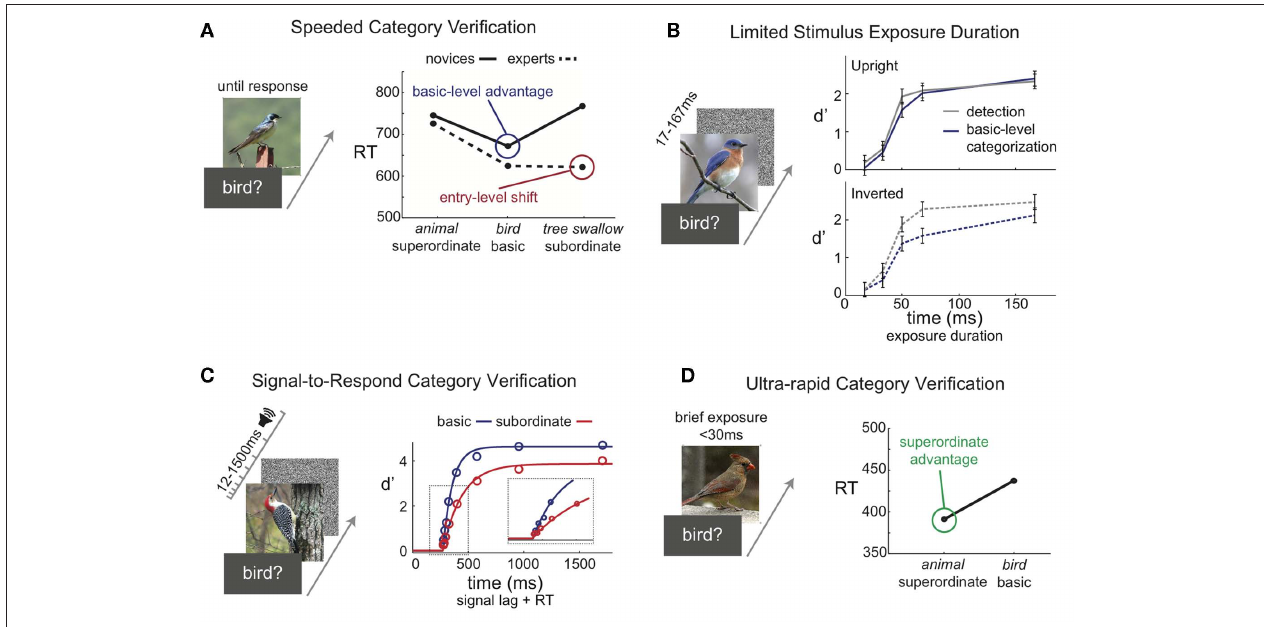
Figure 2 | Data from four common paradigms used to investigate the timing of visual object categorization. (A) Speeded Category Verification Task . On each trial, a superordinate, basic, or subordinate category label is presented followed by a pictured object. Participants verify whether the object is a member of the labeled category. The graph illustrates mean reaction times for categorization by novices (solid line) and experts (dotted line). Novices show a basic-level advantage. Experts show an entry-level shift, where subordinate categorizations are as fast as basic-level categorizations. Data from Tanaka and Taylor (1991). (B) Limited Exposure Duration. The time course of categorization is investigated by systematically varying the exposure duration of a masked stimulus. The top plot shows equivalent performance with upright objects for object detection (gray) and basic-level categorization (blue) for exposure durations ranging from 17 to 167 ms. In the bottom plot, these time courses are dissociated when the stimulus images are inverted, with basic-level categorization worse than object detection. Data from Mack et al. (2008). (C) Signal-to-Respond . The time